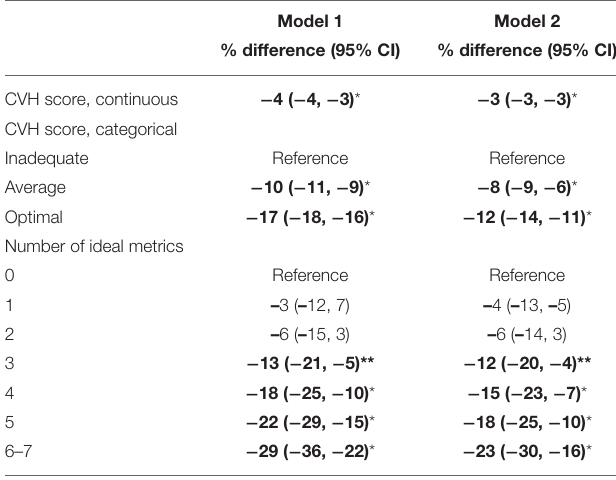
CI, confidence interval; CVH, cardiovascular health; MESA, multi-ethnic study of atherosclerosis. CVH score ranges from 0 to 14. Inadequate score, 0–8; average, 9–10; optimal, 11–14. % difference is the % difference of the geometric mean of HGF calculated from [Exp ( β